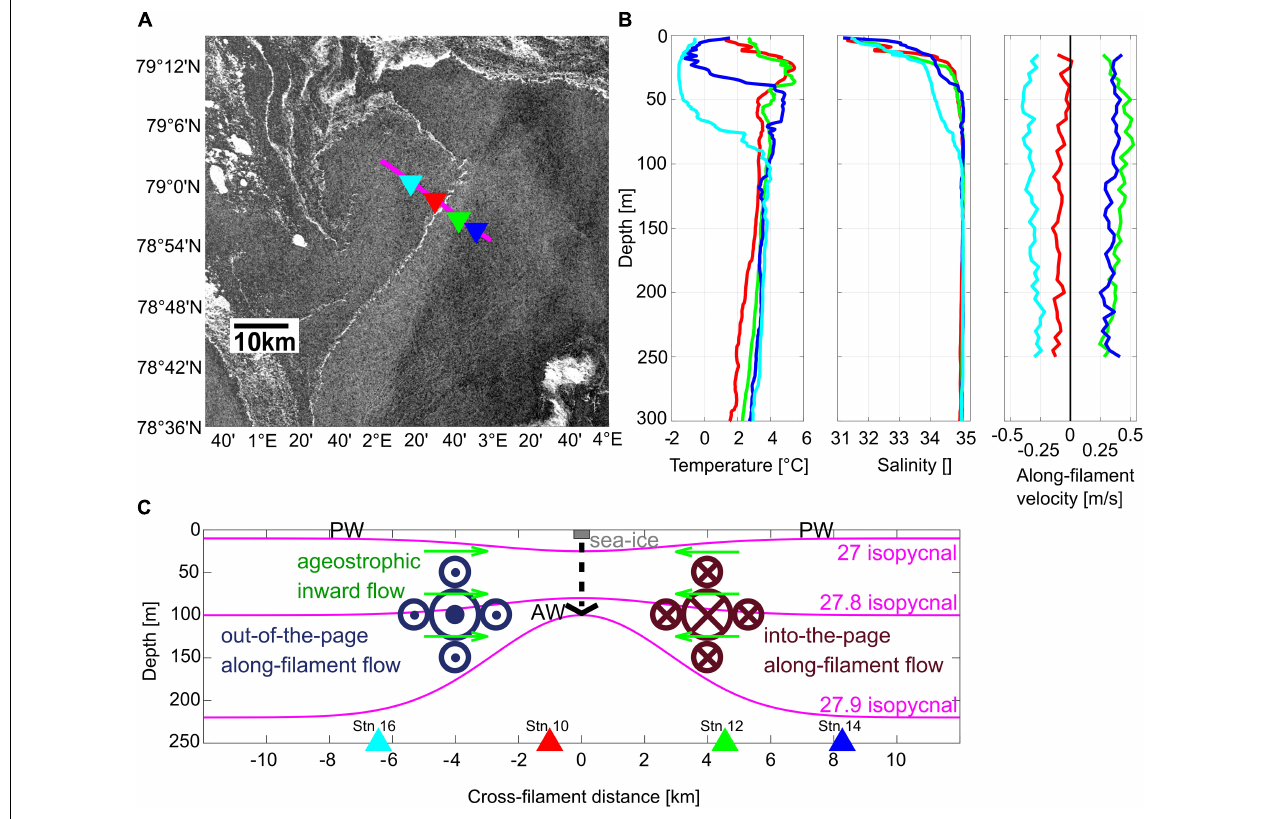
FIGURE 1 | (A) Sentinel 1A (©European Space Agency) radar reflectivity on July 26, 2017 including the position of the cross frontal transect with the four MultiNet stations. (B) CTD profiles of temperature and salinity as well as along-filament velocities at the four MultiNet stations. (C) Schematic illustration of the submesoscale filament in the Arctic marginal ice zone in cross-frontal direction (modified after von Appen et al., 2018). PW, polar water. Colored triangles indicate locations of MultiNet